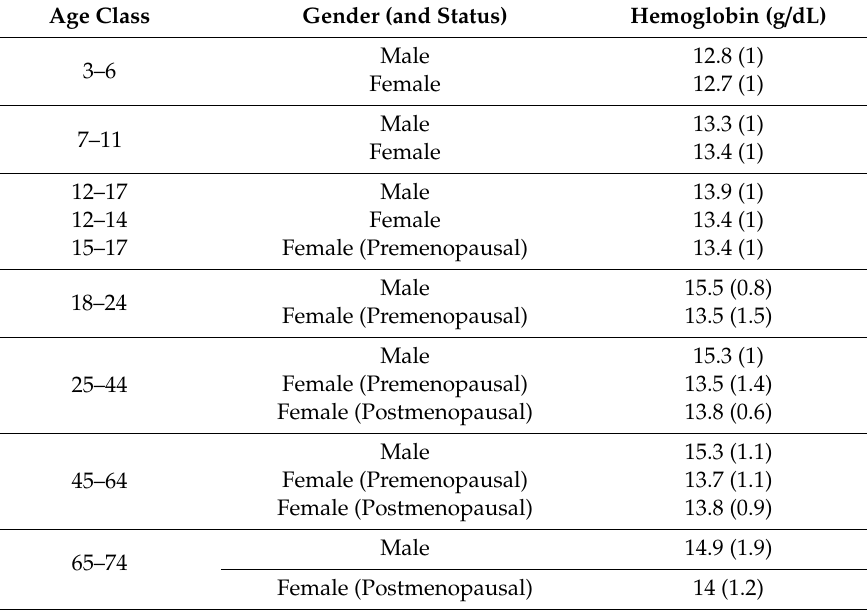
Table A2. Hemoglobin levels of the French population expressed in mean and (standard deviation) used in the present